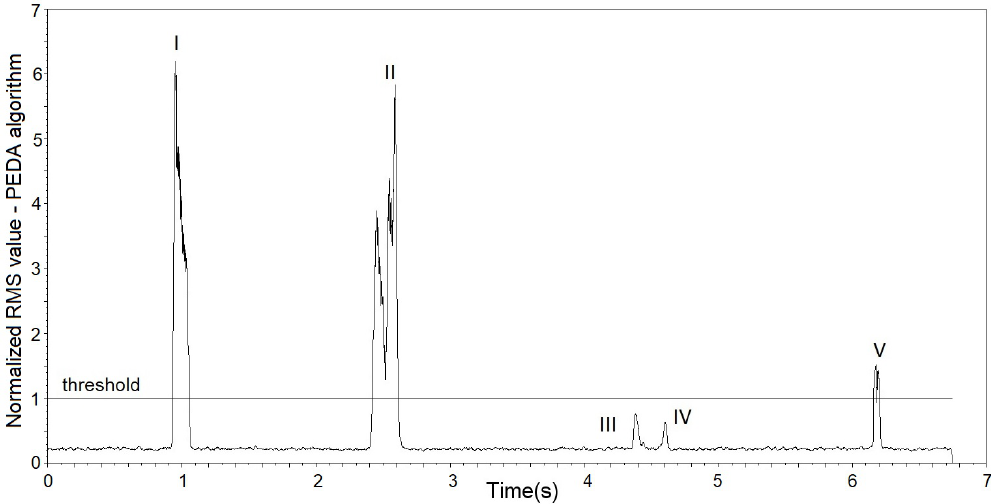
Figure 11. Results of the RMS value using threshold one obtained with the PEDA algorithm applied to the signal of Figure 10, with passages detected in I, II and V and disregarded in III and IV.